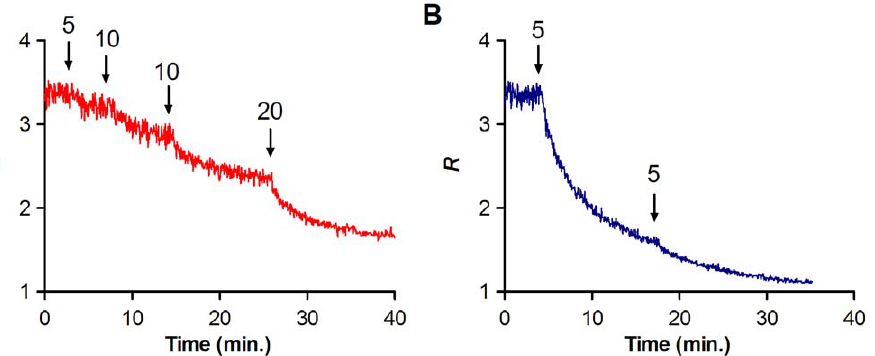
Figure 3. Time course variation of dipole potential in response to the peptides. The effect of the addition of indicated concentrations ( m M) of enfuvirtide (A, red) and T-1249 (B, blue) to labeled erythrocytes was followed by measuring the ratio in real-time. Stepwise additions decreases the ratio within minutes.